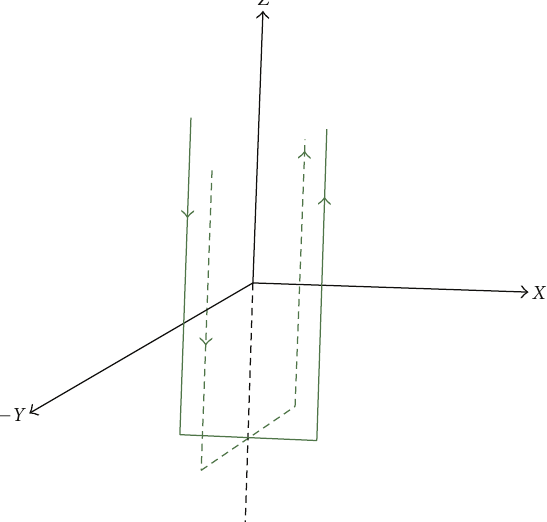
Figure 5: The double U-shaped radiator. This radiator is composed of two U-shaped radiators, one radiator is rotated by π/ 2 radians in the azimuth relative to the second U-shaped radiator, and the phase di ff erence between the currents of the two radiators is π/ 2.